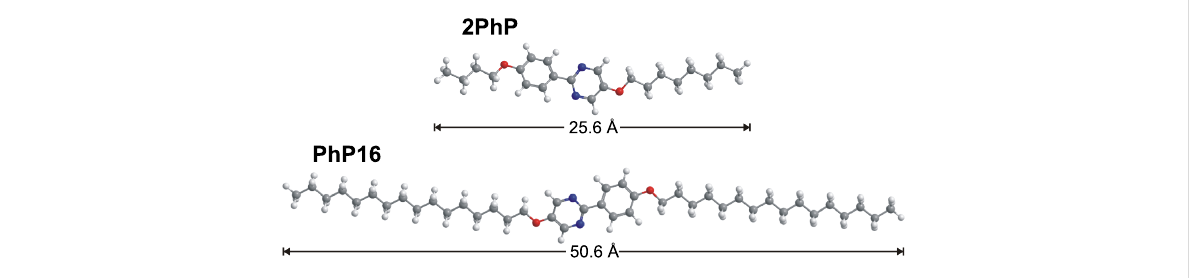
mole fraction x 16 after a slight stabilization until x 16 = 0.1, and it disappears at x 16 = 0.4. In the smectic state, the SmA phase is much more stable than SmC. Although SmC is the dominant phase in both pure compounds, the SmC phase disappears after the addition of only 5 mol % of the long compound PhP16 . On the other side of the phase diagram, the SmC phase is stable until a mole fraction of x 16 = 0.6 is reached. Over a broad range of temperatures and concentrations, SmA is the dominant phase in the diagram.